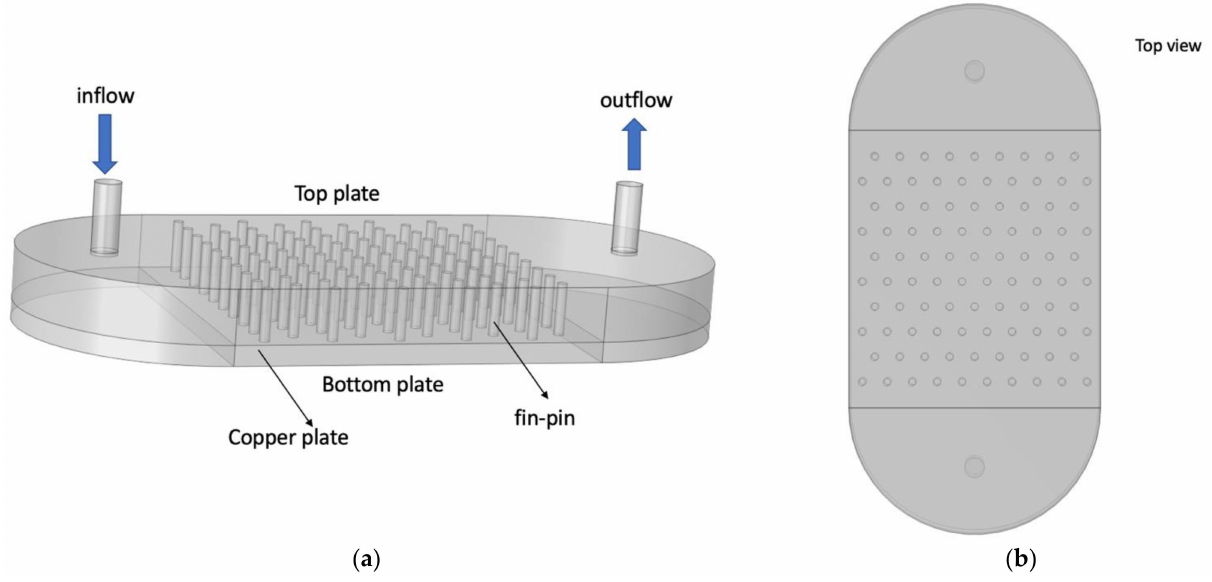
Figure 3. Experimental [30] and current numerical